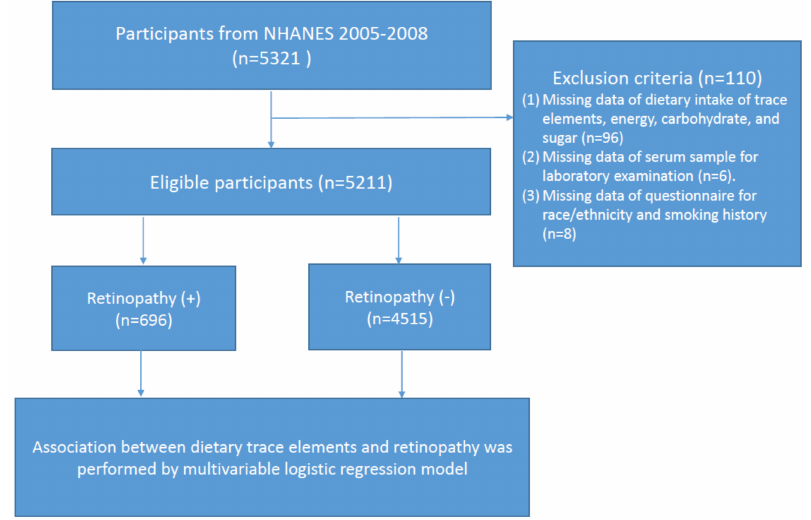
Figure 1. Flow chart of the